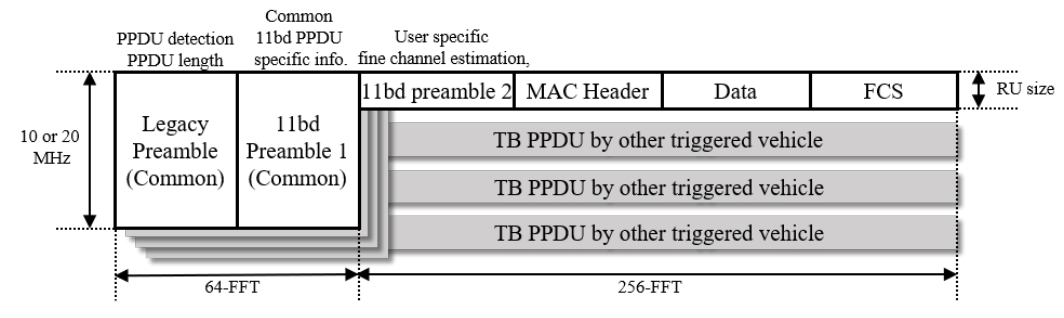
Figure 2. The general format of the proposed TB